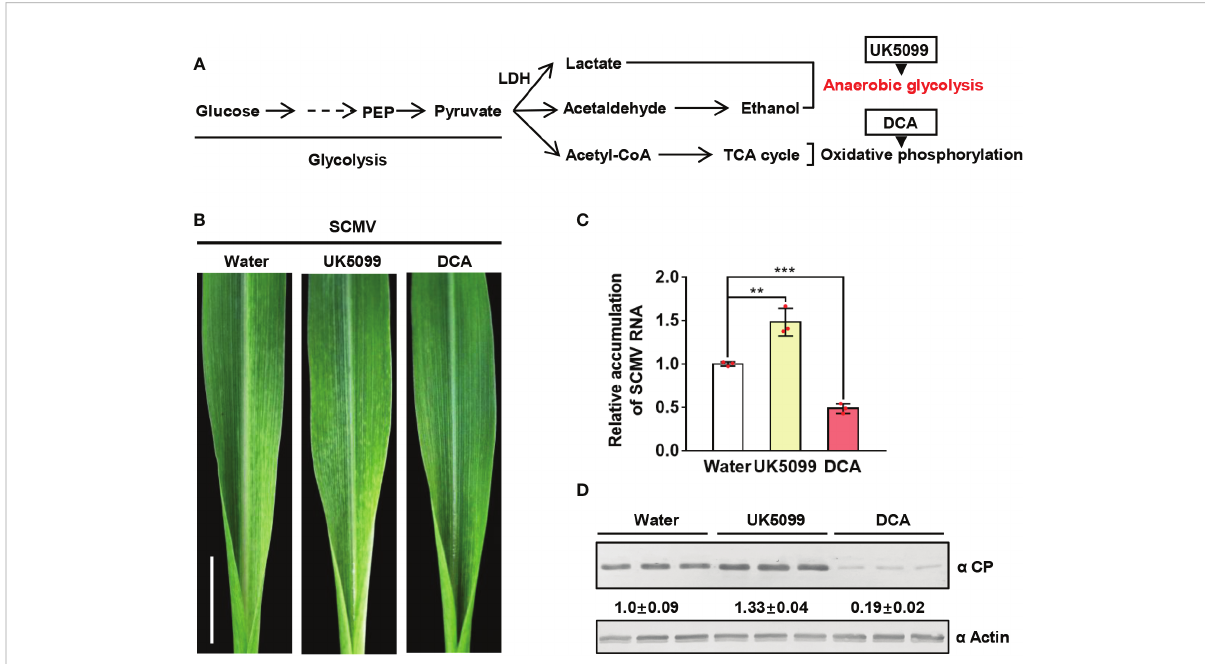
FIGURE 2 Induction of anaerobic glycolysis promotes SCMV infection. (A) Simpli fi ed scheme of the glucose metabolic pathway. The end product of glycolysis, pyruvate, is further metabolized to lactate and alcohol in the anaerobic metabolic pathway or to acetyl-CoA in the oxidative phosphorylation pathway for the TCA cycle. UK5099 and DCA were used to induce anaerobic glycolysis and oxidative phosphorylation, respectively. (B) Mosaic symptoms in UK5099-treated plants were more severe than that of water-treated plants, whereas those in DCA-treated plants were milder than in water-treated plants. Scale bars = 1 cm. (C) Relative accumulation levels of SCMV genomic RNA, determined by RT-qPCR, in 1 SLs of the water-, UK5099- or DCA-treated plants at 5 dpi. The results are represented as the means ± SE (n=3). Statistical differences between the treatments were determined using unpaired Student ’ s t -test (two-tailed), ** P < 0.01; *** P < 0.001. (D) Accumulation levels of SCMV CP in 1 SLs of the water-, UK5099- or DCA-treated plants at 5 dpi through western blotting analysis. The samples harvested from the water-treated plants were used as controls. The detected protein bands were visualized using the ImageJ software. The numbers between the two panels are the relative ratios of SCMV CP accumulated in UK5099- or DCA-treated plants verses the control plants. The amount of SCMV CP in the control plants is arbitrarily presented as 1.0. The actin bands in the lower panels are used to show sample